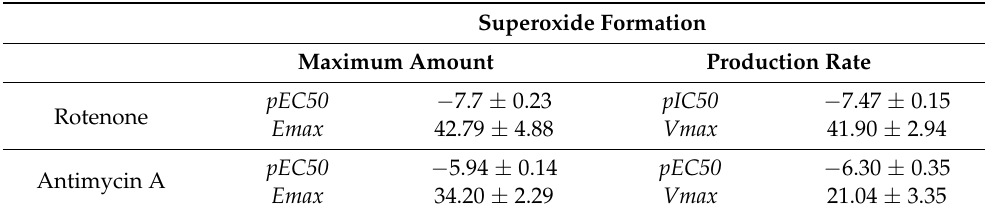
Figure 2. ( A ) Concentration–response curves obtained from the maximum superoxide formation evoked by NADH in the presence of mitochondrial electron transport chain inhibitors of the complex I (rotenone) and III (Antimycin A). ( B ) Superoxide formation rate evoked by NADH in the presence of rotenone and antimycin A determined from the lineal range of the kinetic assays. ( A ) Nonlinear regression was performed with log(agonist) vs. response model and least squares regression as fitting method. ( B ) Nonlinear regression was performed with log(inhibitor) vs. response model for rotenone and log(agonist) vs. response model for antimycin A. In both cases, least squares regression was used as fitting method. Table 1. Logarithms of half-maximum effective or inhibitory concentrations ( pEC50 or pIC50 ), maximum superoxide formation ( Emax ), and maximum superoxide formation velocity ( Vmax ) determined from concentration – response curves for each specific inhibitor.